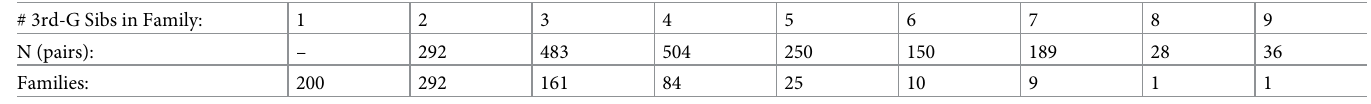
Table 3. Distribution of third generation siblings included in data by sibship